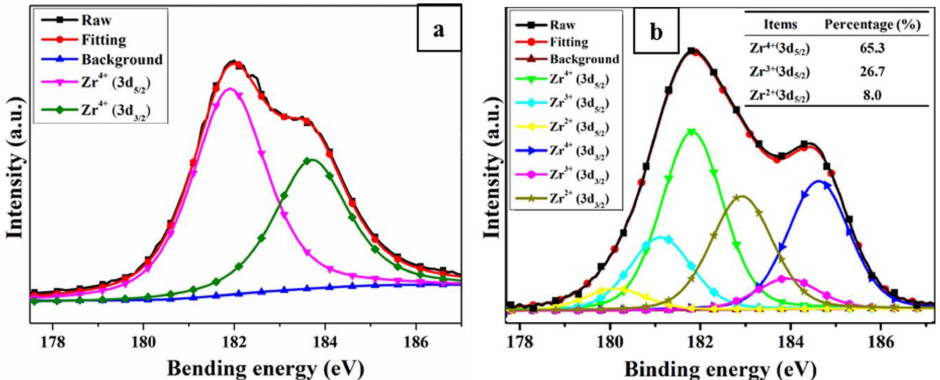
Figure 9. XPS spectrum of Zr(3d) for SR/Zr-POSS-4 nanocomposites before ( a ) and after aging ( b